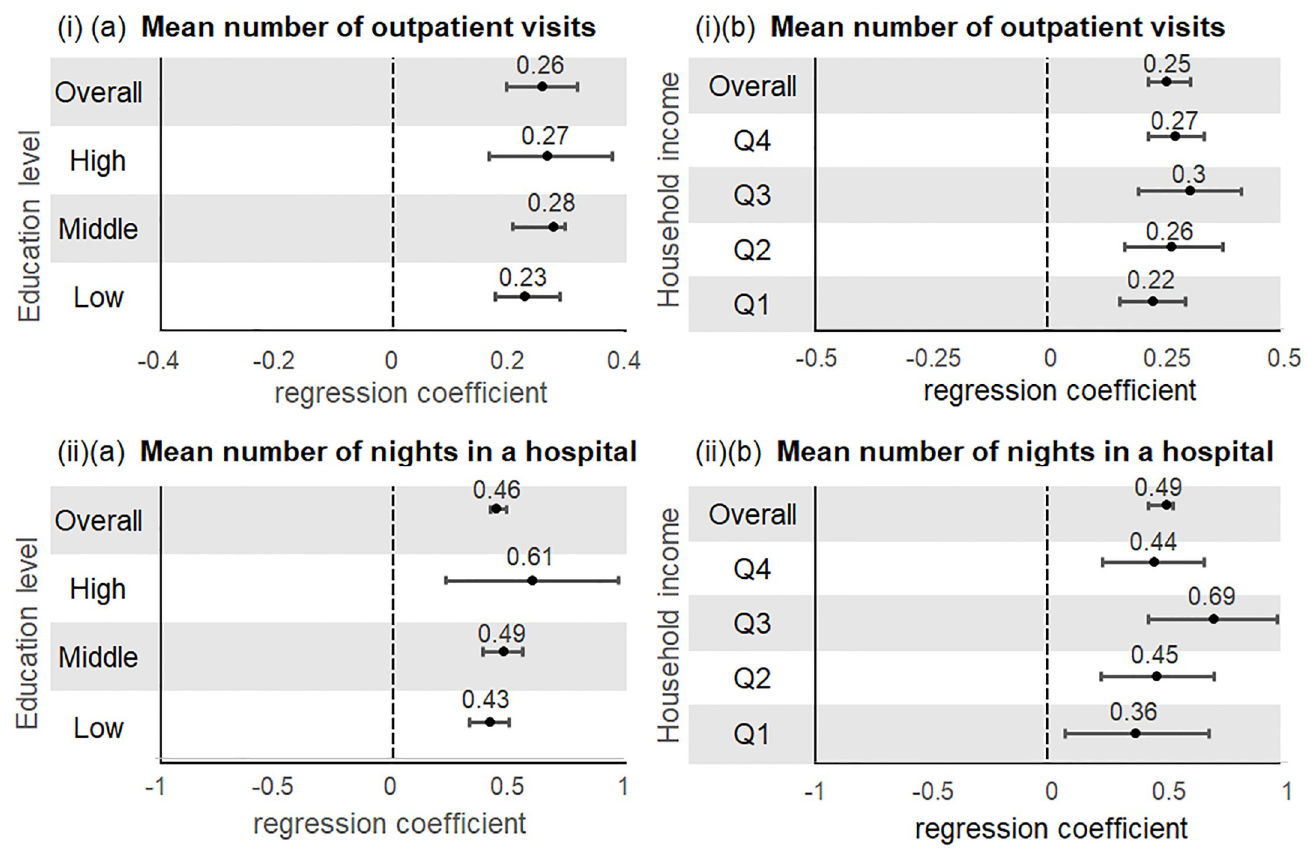
Fig 5. Associations between multimorbidity with mean number of (i) outpatient visits and (ii) nights in hospital by (a) education level and (b) household income (Australia) + . + Multivariable negative binomial regression models were adjusted for age, sex, marital status, employment, household income (if stratified by education)/education (if stratified by household income), geographical status, country of birth, aboriginal status, body mass index, physical activity, alcohol intake, and smoking.